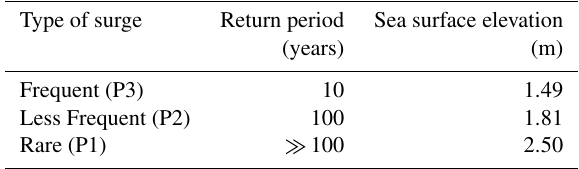
Table 4. Total water elevation for the different types of sea storms considered in the FD and corresponding return periods (Perini et